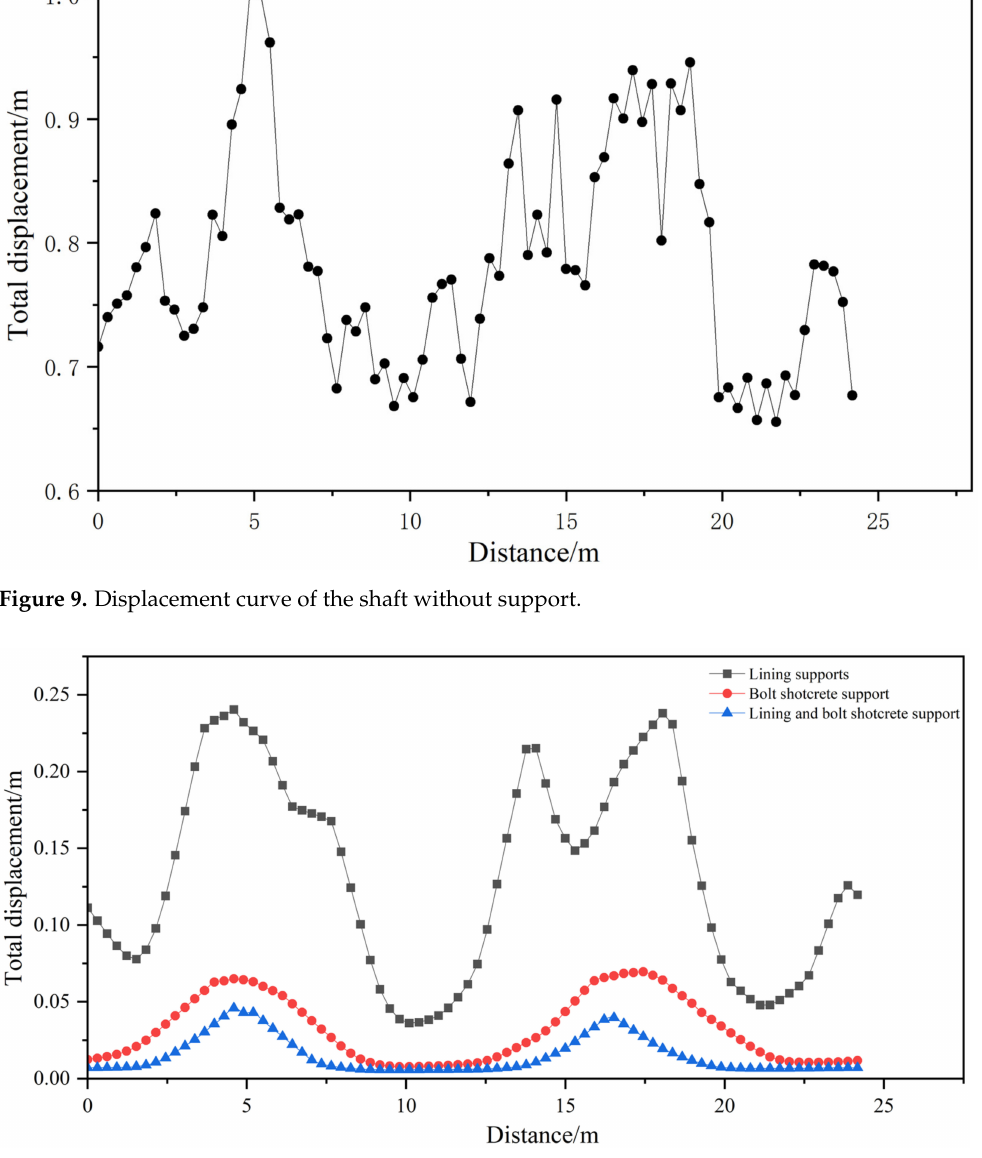
Figure 10. Displacement curves of the shaft with different